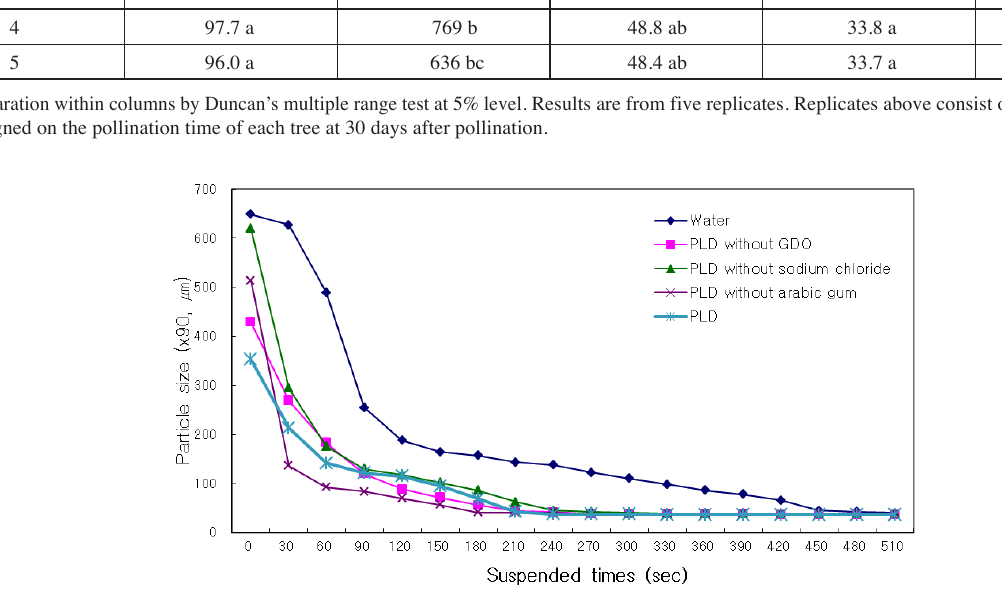
Fig. 4: Changes of particle sizes with compositions of the pollen liquid diluent (PLD) during suspended time.